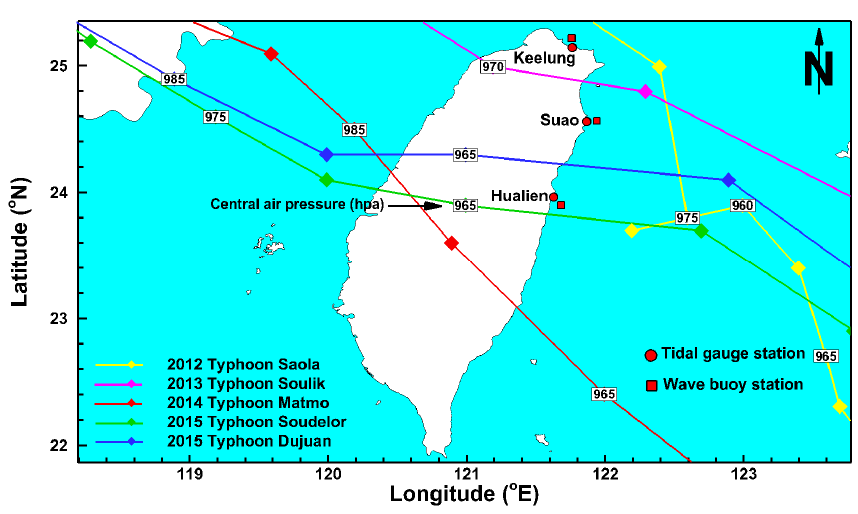
Figure 3. Tracks of typhoons and locations of tidal gauge stations and wave buoy stations used for model validation.